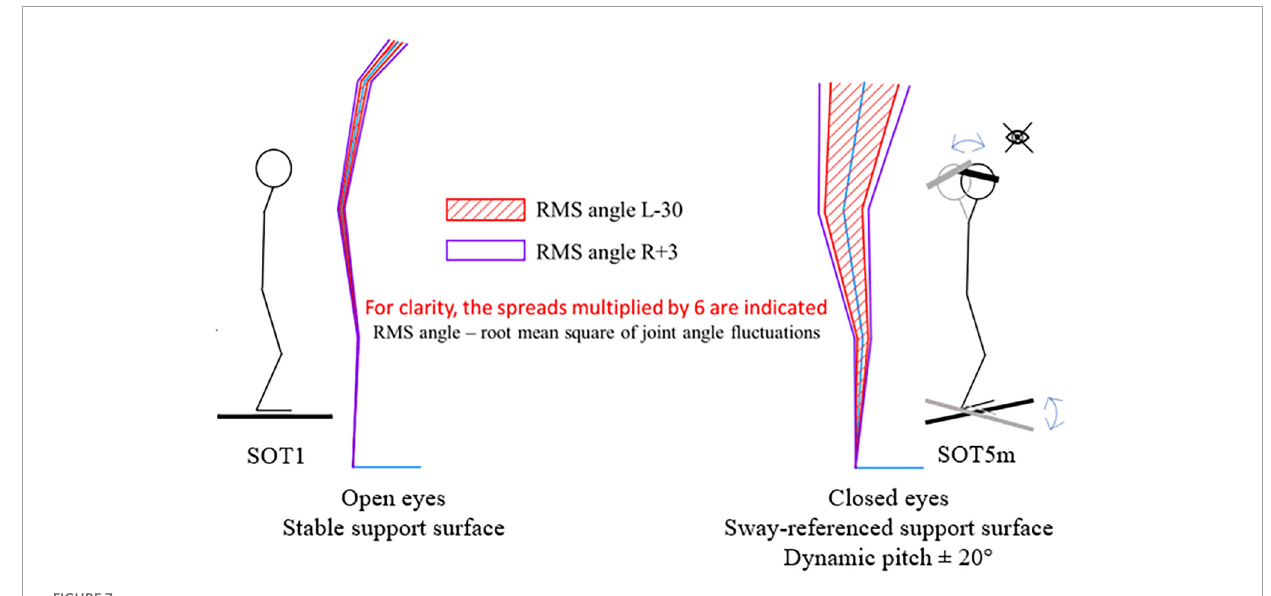
FIGURE7 Increase of angles RMS between SOT1 and SOT5.